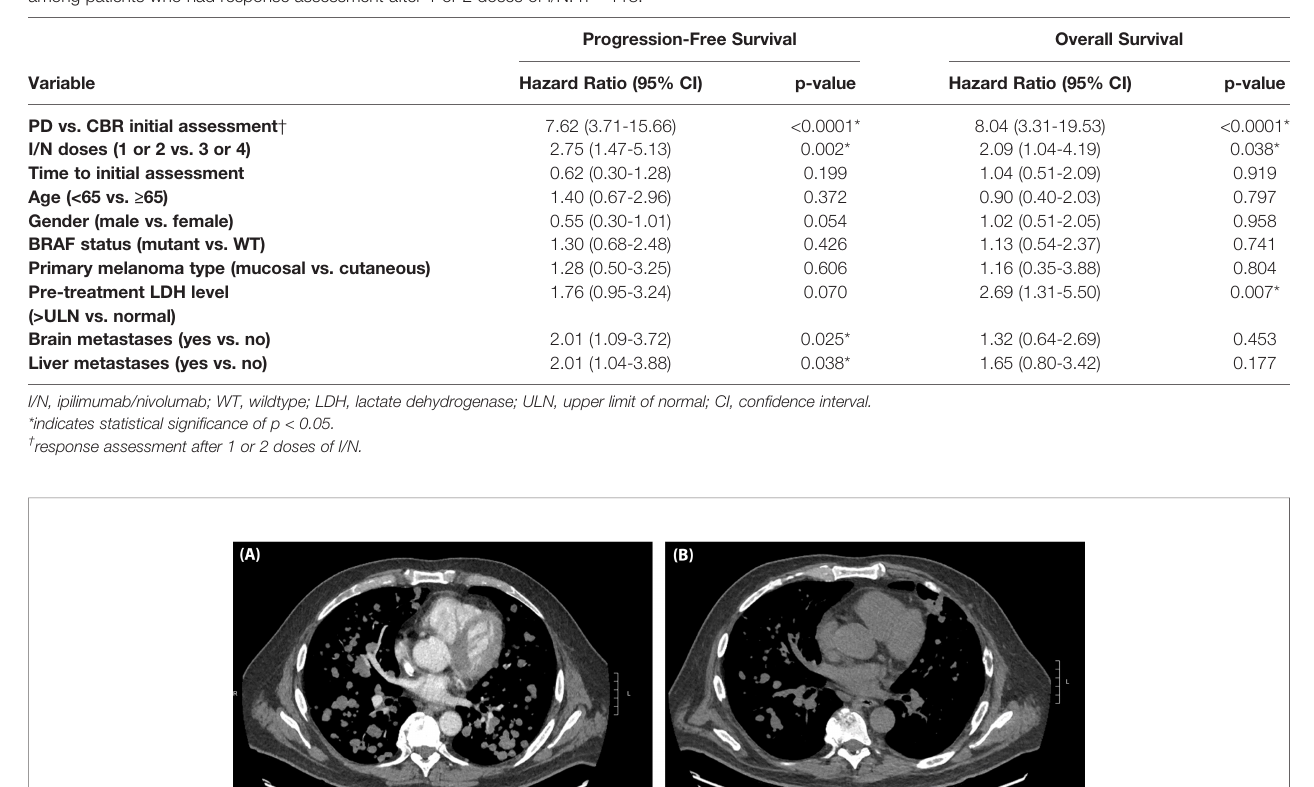
( Supplementary Table 3 ) and multivariable Cox regression